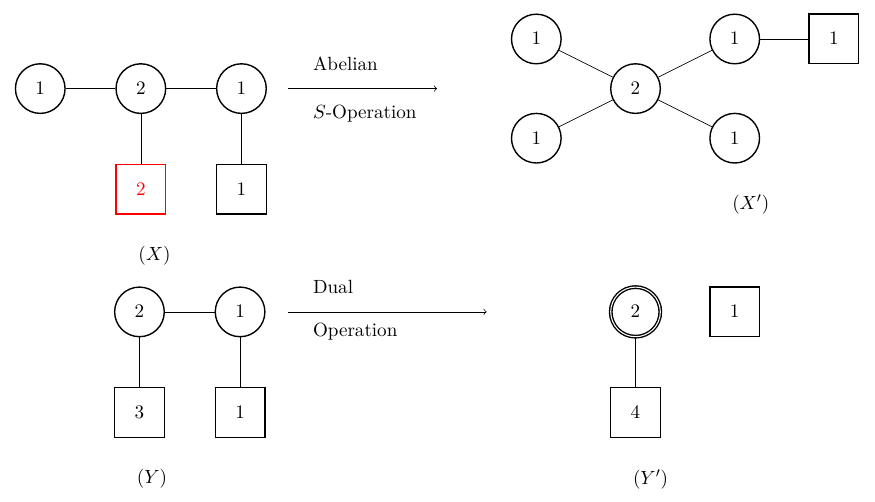
Figure 42 . This figure shows the action of an Abelian S -type operation (involving two elementary gauging operations) on the quiver X and the dual operation the quiver Y of figure 39 respectively. The quiver X 0 is mirror dual to the quiver Y 0 .